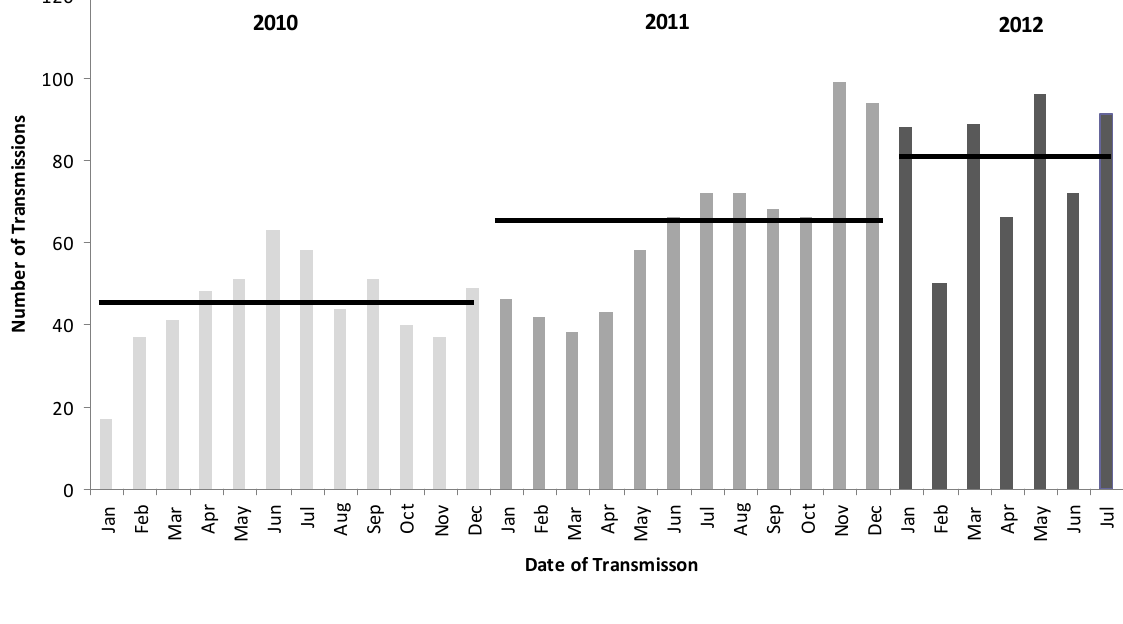
Figure 1. Uptake of service between January 2010 and July 2013; horizontal bars represents the mean number of transmissions per year or part thereof.